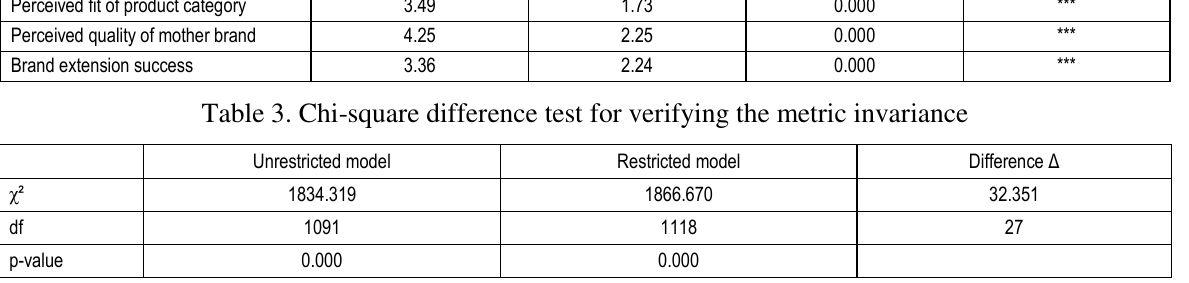
Table 4. T-test for verifying significant differences of the path